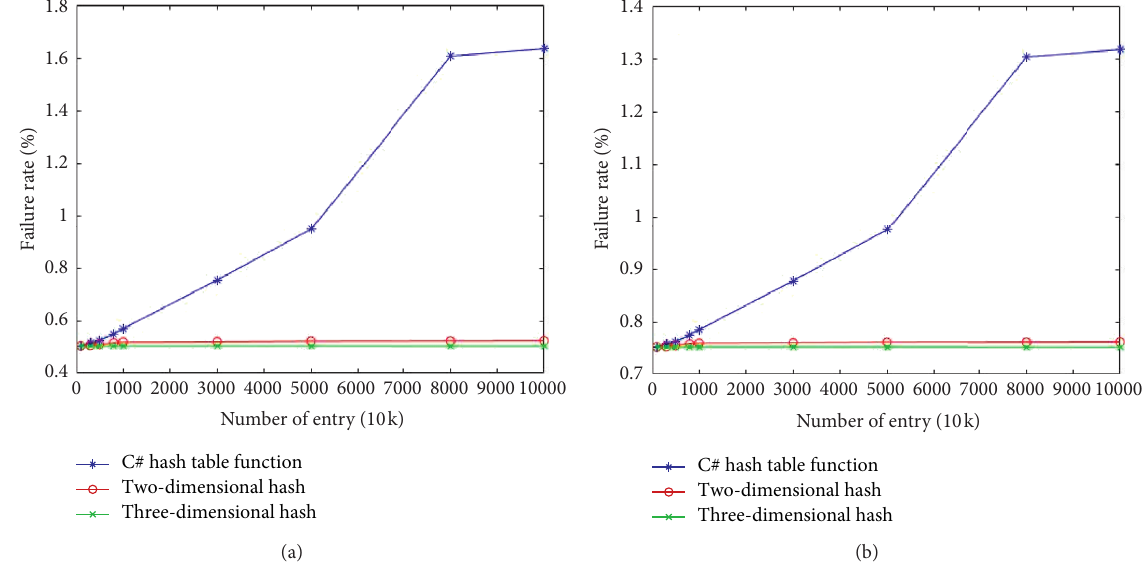
Figure 12: Comparison on failure rate at (a) 0.5 fill rate; (b) 0.75 fill rate.